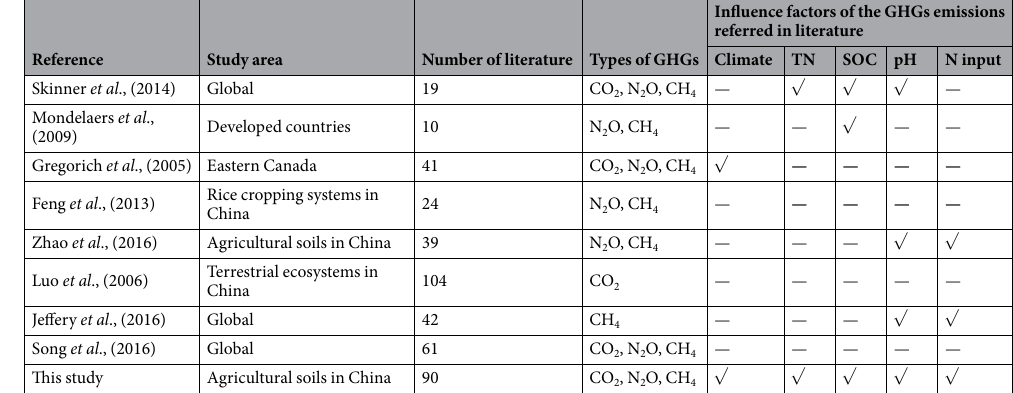
Table 1. Comparison of this study with other Meta-analysis on the GHGs emission from the organic amended soils. Note: “ − ” means the dataset was not included in the literature. “ √ ” means the dataset was not included in the